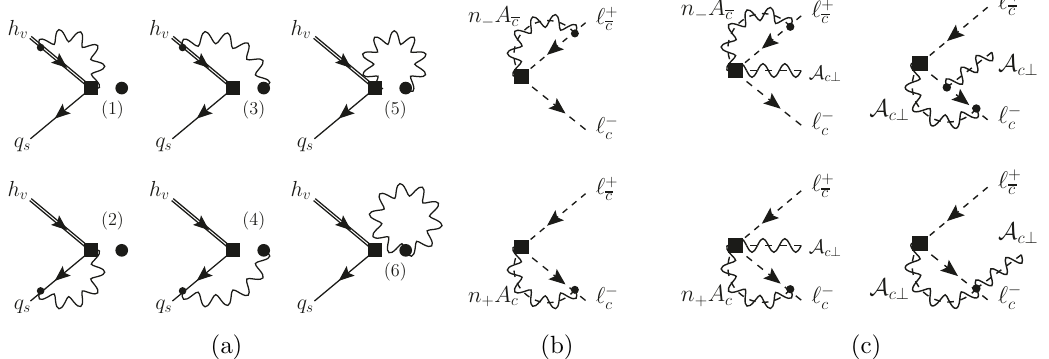
Figure 4. The diagrams in (cid:12)gure 4(a) show the parts of the SCET II operators with soft photon exchange (wavy lines) from i ) the Wilson lines in the soft (cid:12)elds h v (double line) and q s (single line) depicted by the square and ii ) the product of soft Wilson lines Y y by the solid blob. They contribute to the Z QED Q 2 ). Figure 4(b) shows diagrams relevant for Z c , Z c ‘ / The dashed lines depict the lepton and anti-lepton and the wavy-dashed lines the (anti-) collinear photons from the corresponding Wilson